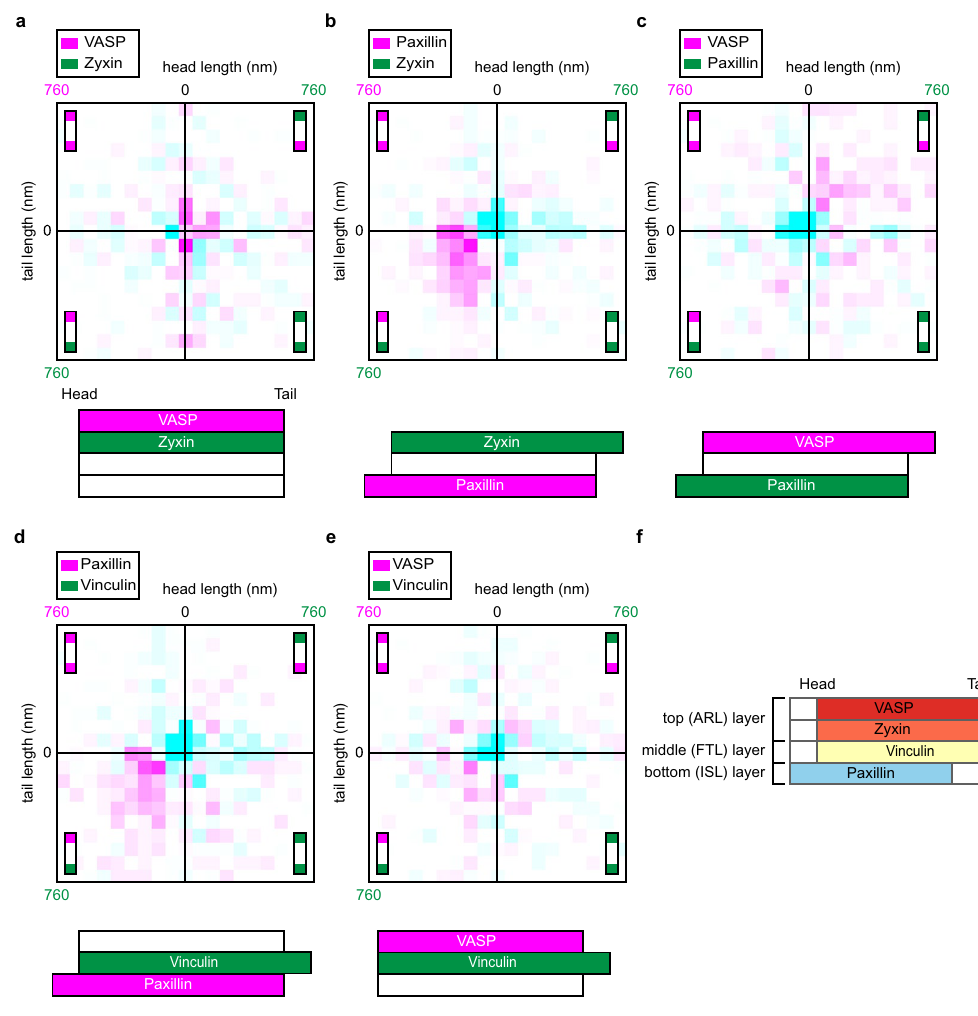
Figure 4. 2D-histograms combining the head and tail protrusion lengths of individual FAs. ( a – e ) The data presented in Fig. 3 shown as 2D-histograms combining both the head (horizontal axis) and the tail (vertical axis) protrusion lengths for each individual FA. Colours represent the difference between the relative distributions of the reference set and the indicated protein pair. White: below threshold (see Materials and Methods), magenta: increase relative to reference set, cyan: decrease relative to reference set. Colour intensity represents magnitude of the change (for scale see Materials and Methods). Cartoons below provide a schematic summary of the data (not to scale). ( f ) A side view model for the longitudinal distribution of proteins along FAs based on the data from the different co-expressed FA protein pairs and the z-layer each protein is found in according to the seminal paper by Kanchanawong et al. 7